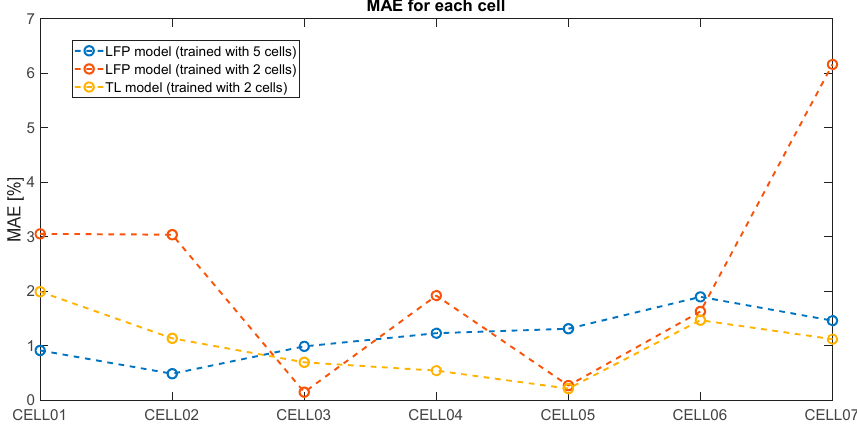
Figure 6. MAE for each cell with the different models.